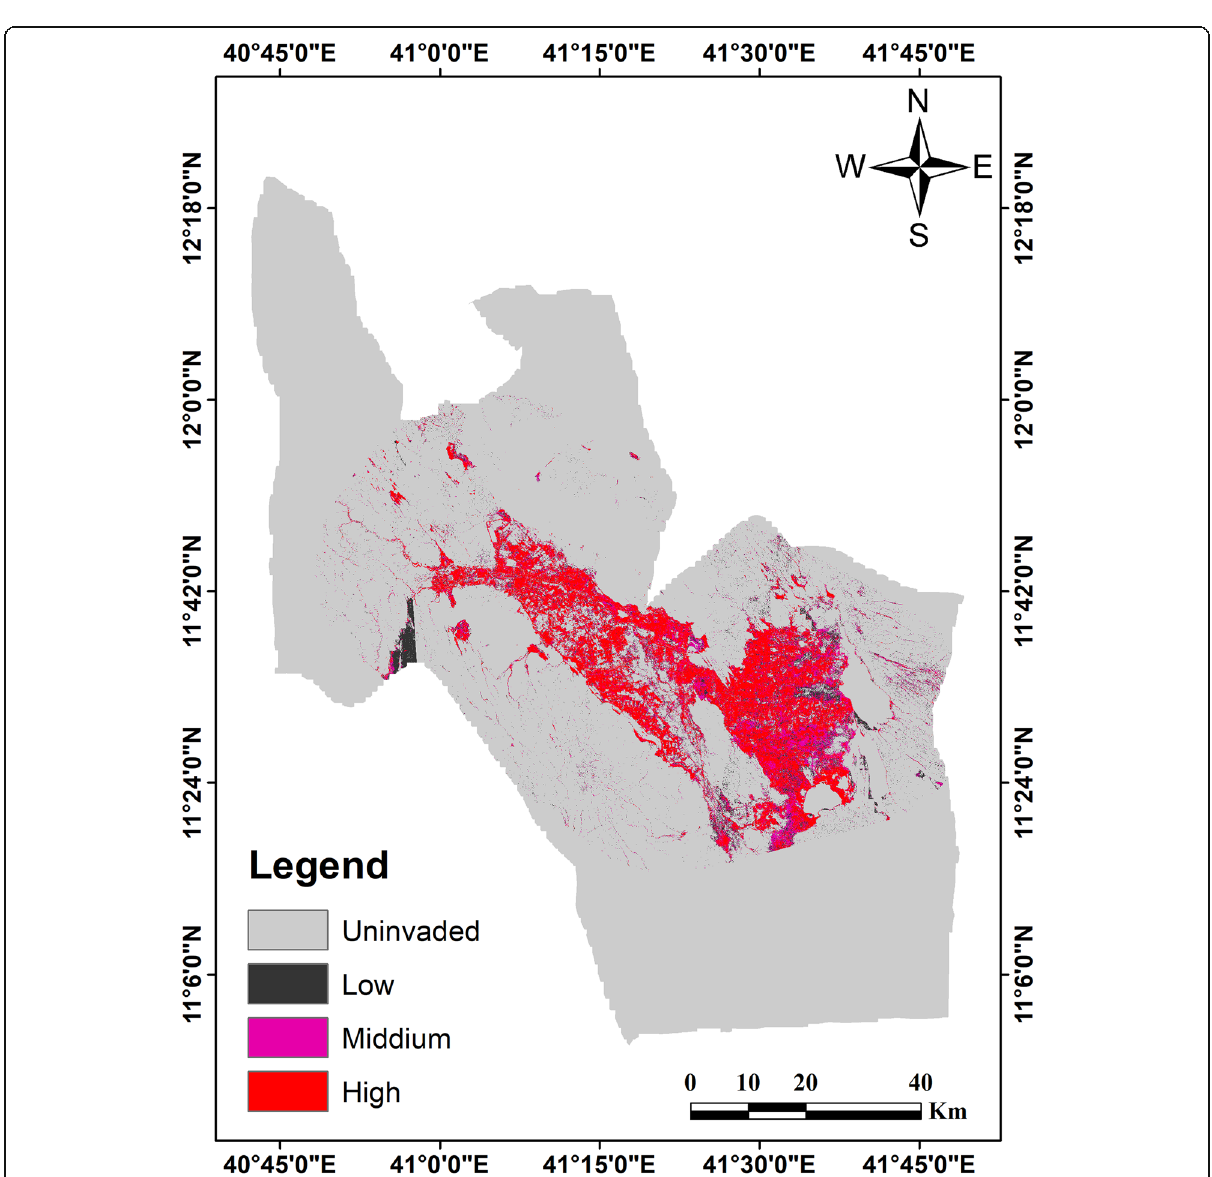
Fig. 5 Ensemble model produced from RF, SVM, BRT, GLM, and GAM for modelling and mapping of Prosopis habitat suitability distribution. The gray, black, pink, and red colors describe “ uninvaded, ” “ low, ” “ medium, ” and “ high ” invasion by Prosopis ,